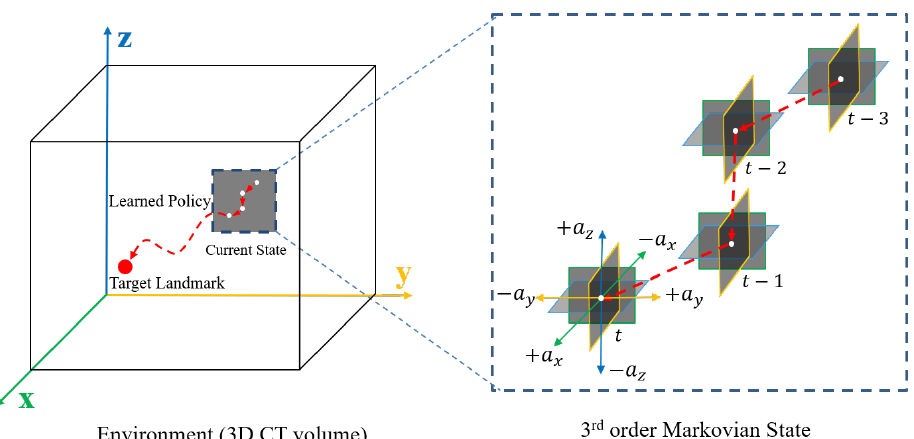
Figure 2. Schematic diagram of an environment: The CT volume is defined as the environment, and the trained agent aims to find the target location optimally. Local 2.5D patches at the current position t along the 3D trajectory are configured using the state of four histories { s t − h | 0 ≤ h ≤ H } such that the orientation can be learned together. H is the order of the Markovian property and H = 3 in the example. The action set A = {± a x , ± a y , ± a z ,0 } consists of six three-dimensional actions, including a stationary